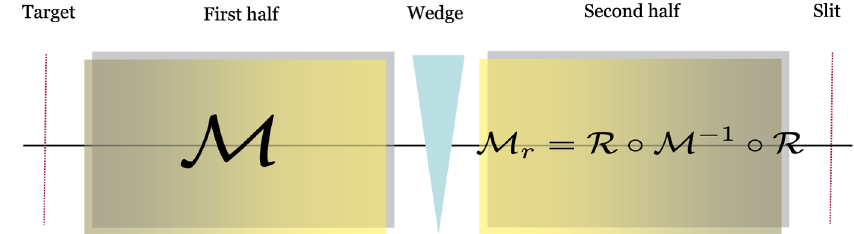
FIG. 1. (Color) Layout of a one-stage separator. The map of the second half is given by symmetry operations. The full system is designed to be a high order achromat when there is no wedge in the middle. The placement of the achromatic wedge at the mirror- symmetric point of the system should disturb minimally the properties of the initial